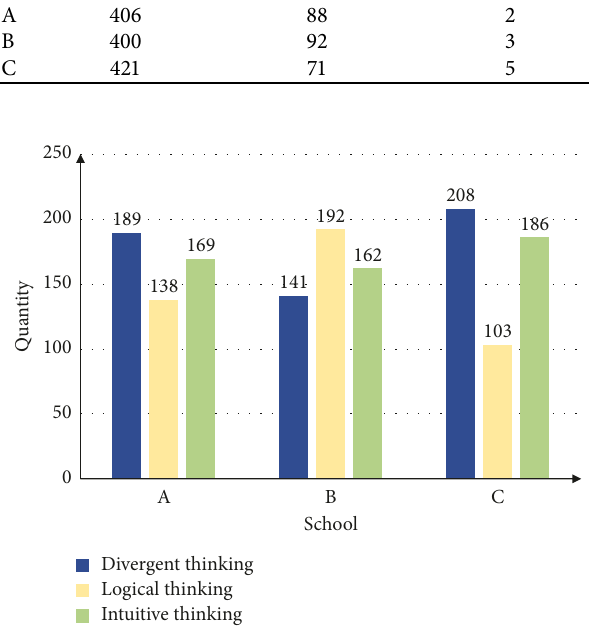
Figure 6: Survey results of the thinking situation that physical education students mainly cultivate.